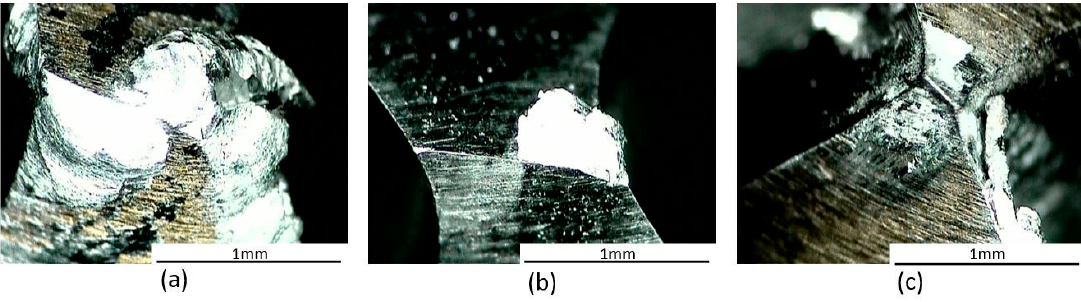
Figure 2. Worn drills ( a ) HSS-Ti; ( b ) HSS-Mo; ( c ) HSS-Co.